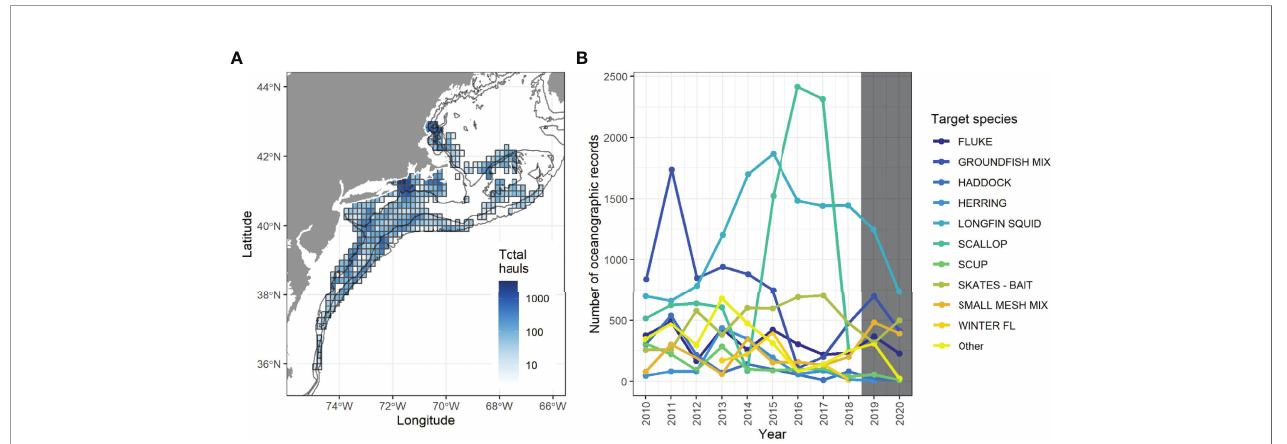
FIGURE 7 | The trend in oceanographic records across space and through time. Panel (A) shows the density of sampling across space for all years sampled (2010-2019). Cells with fewer than three unique permits (records from fewer than three vessels) have been omitted. Panel (B) shows the number of hauls with registered oceanographic data from 2010 to 2020. Data from 2019 and 2020 (shaded gray) are still being processed and sums represent incomplete totals. In panel (A) 223 (40%) cells were